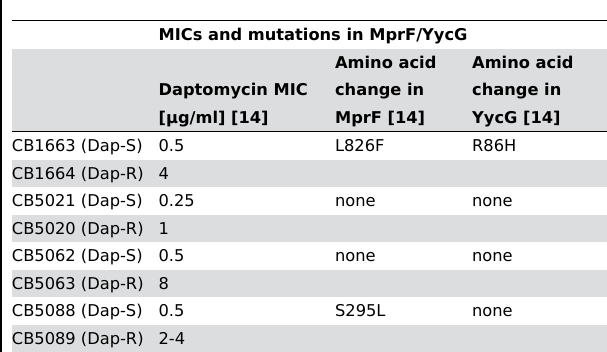
Table 1. Bacterial strains.